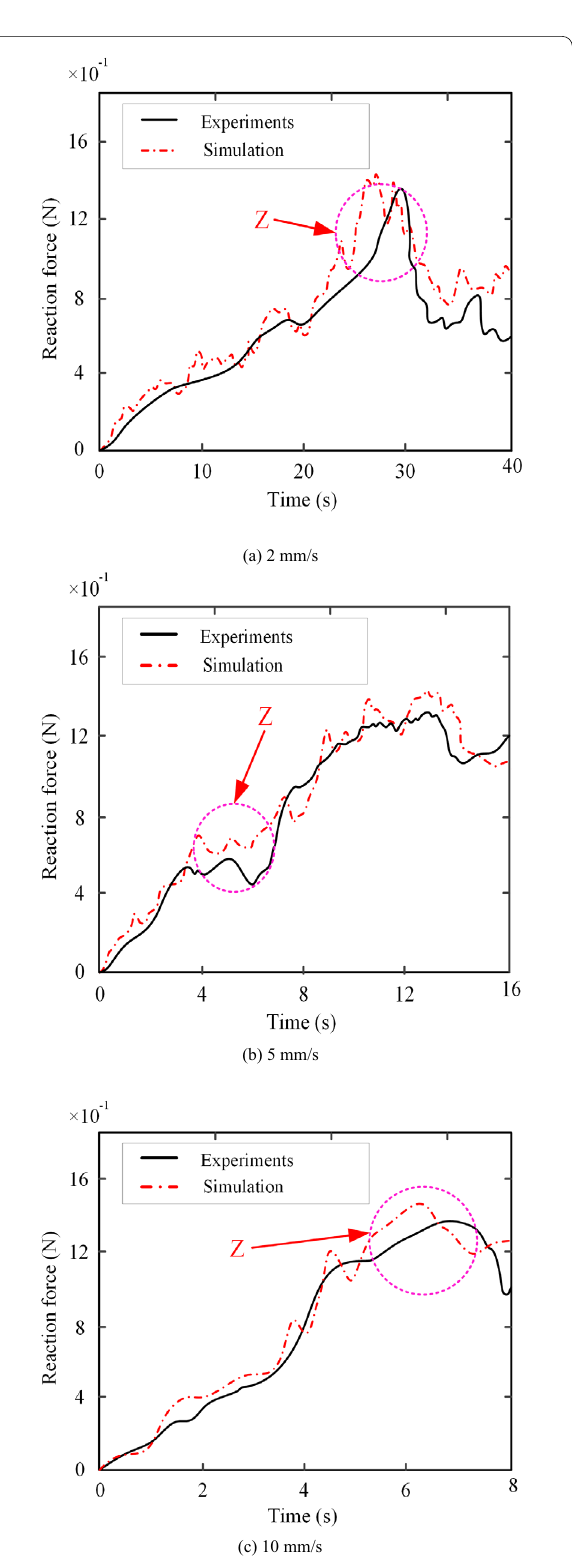
Figure 14 Reaction force of puncture needle at different puncture